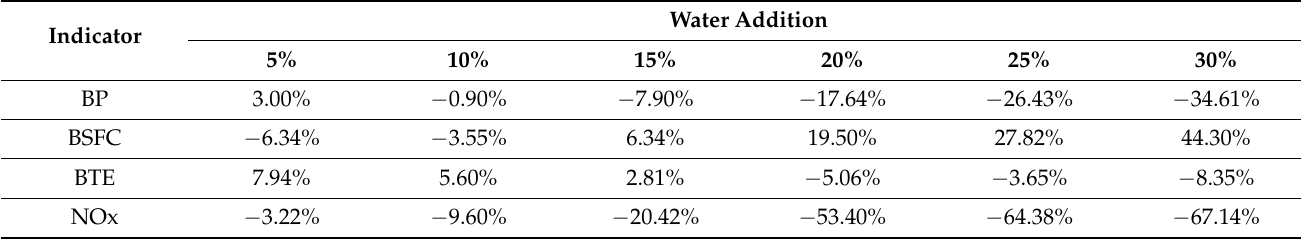
Figure 8. The fluctuation of BP (kW) as a function of rotation speed and water concentration. Table 2. The average changes in BP, BSFC, BTE, and NOx for CI engines driven by various percentages of W/D emulsion fuel against pure diesel